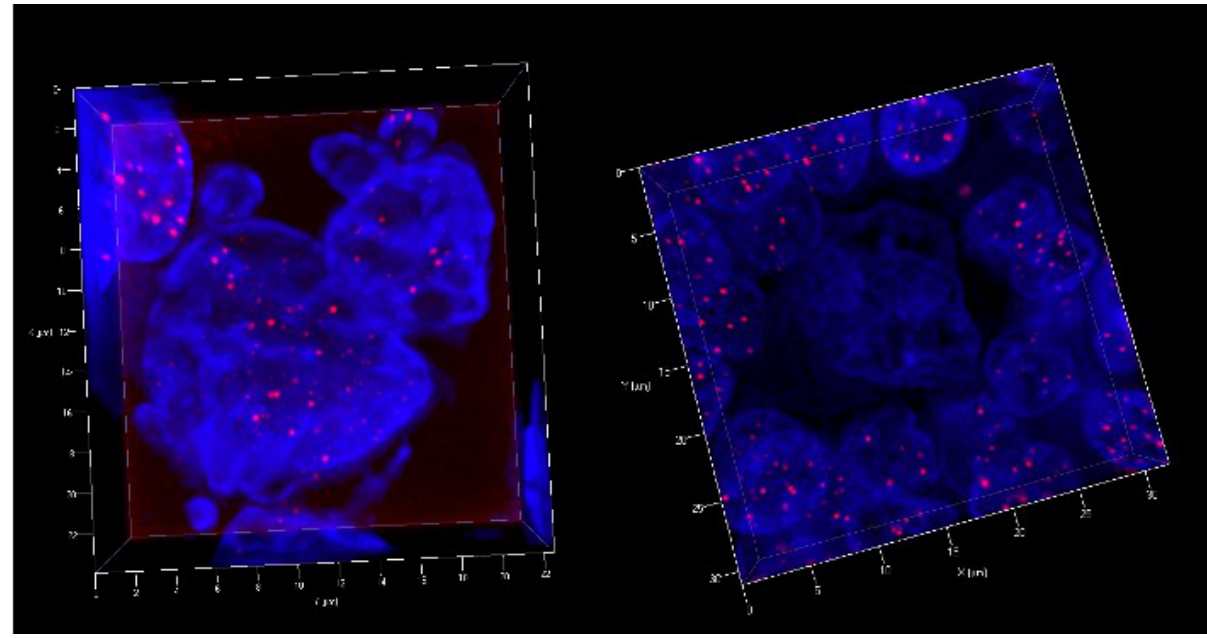
Figure 3. Combined 3D nuclear staining (telomeres red; nuclear DNA blue) shows a bi-nucleated RS-cell (left) with three small satellite nuclei and high telomere number. A typical “ghost” RS-cell surrounded by a corona of lymphocytes is shown at the right. In both cases the patients entered rapid, still ongoing,